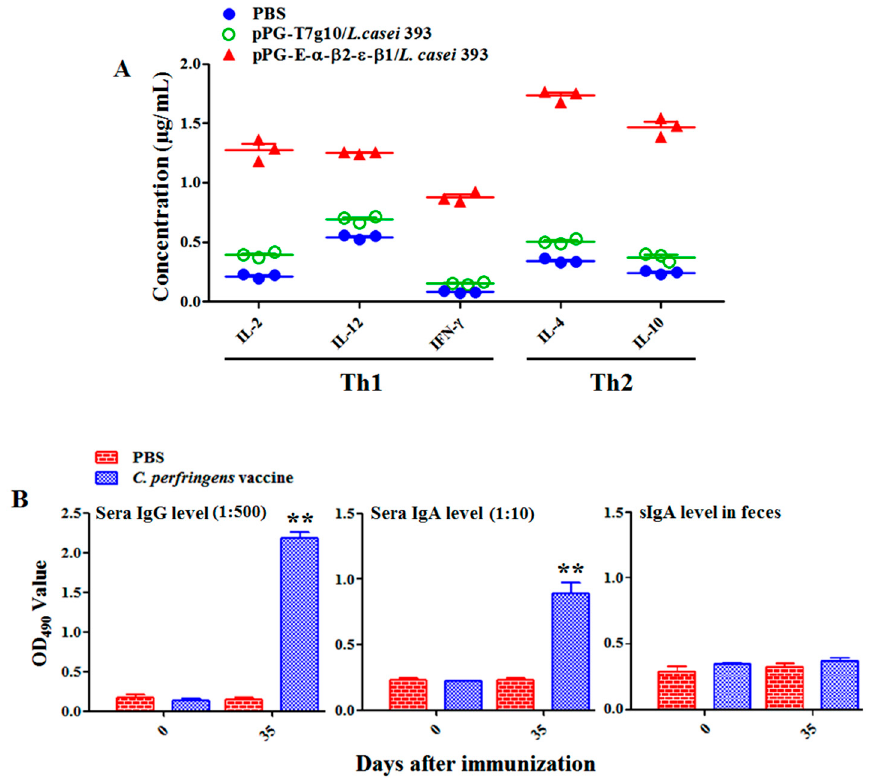
Figure 6. The levels of cytokines IL-2, IL-4, IL-10, IL-12, and IFN- γ in serum samples were determined using ELISA ( A ), and the antibody levels in the rabbits immunized by commercial vaccine via injection ( B ). The results are presented as mean ± SD of each group (* p < 0.05, ** p <